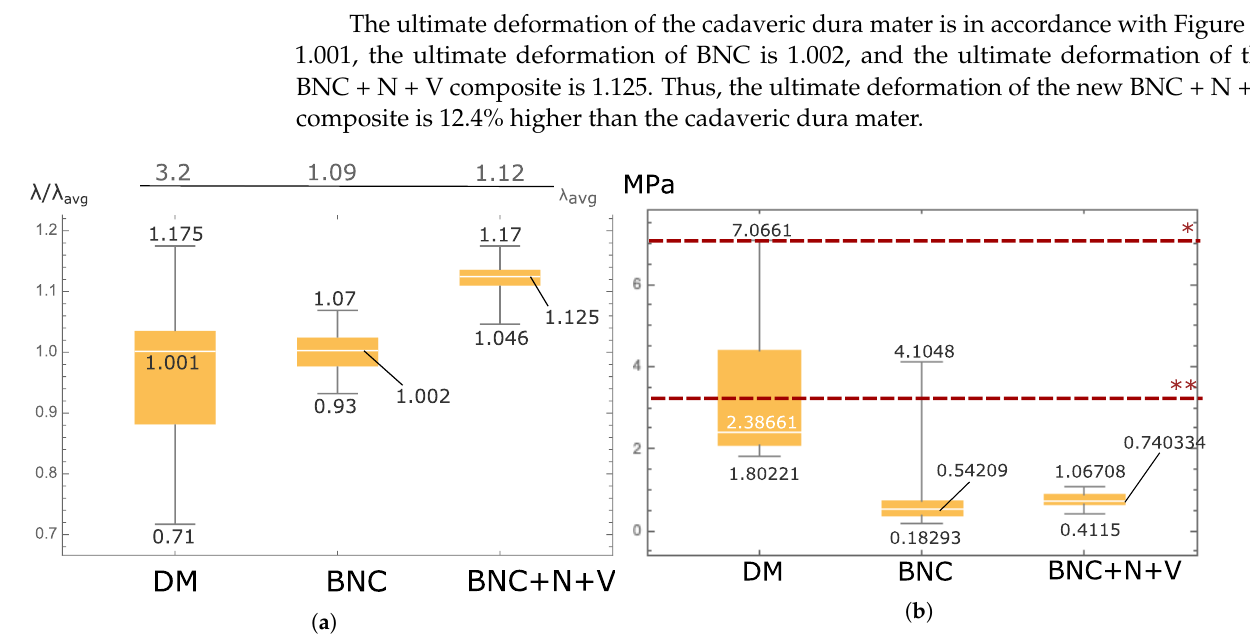
Figure 7. Boxplot for values of ultimate strain ( a ) and stress ( b ). The lines (*) and (**) correspond to data of the same value from [35] of DM and Tutopatch ® material. Reprinted from